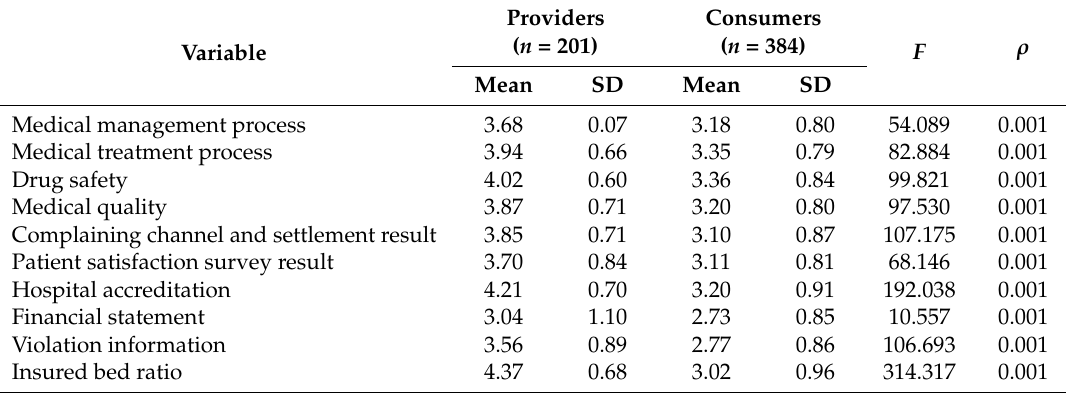
Table 5. Analysis of variance of mandatory information